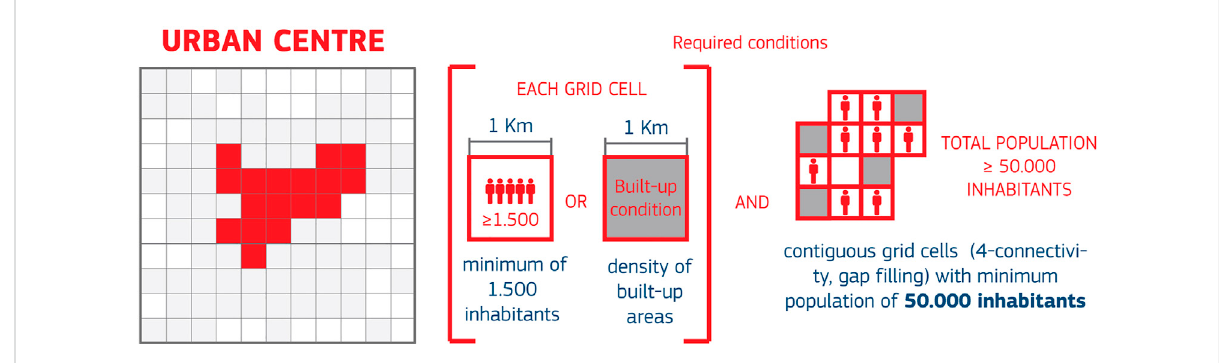
FIGURE 2 Schemarepresentinganabstracturbancentreinthegridcellenvironmenttoillustratepopulationsize,density,andbuilt-upareadensitycriteria to de fi ne urban